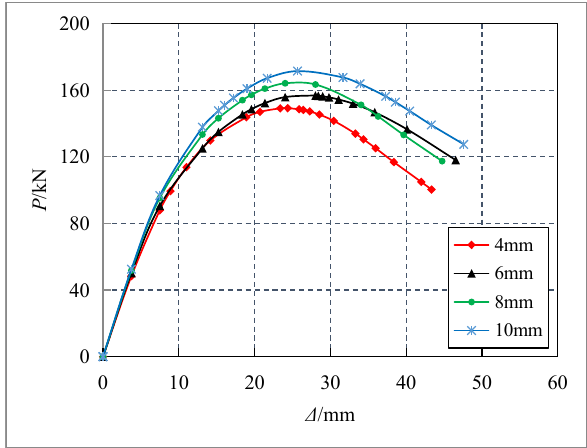
Figure 19. Influence of profile web thickness on composite joints. Table 7. Influence of profile web thickness on characteristic points of composite